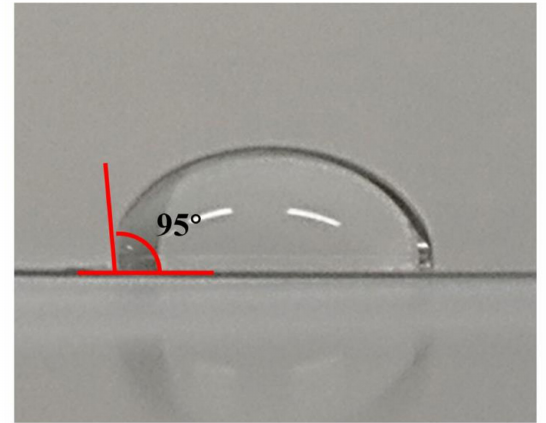
Figure A3. Photograph of the contact angle θ